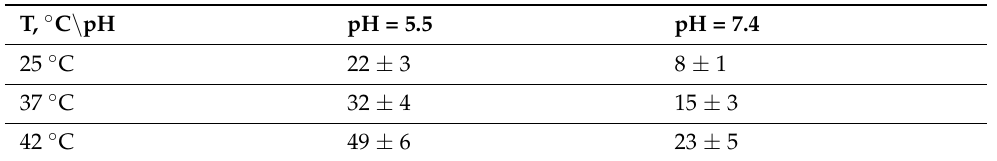
Table 3. Initial rate of Dox release (%/h) at pH = 7.4 or 5.5 and T = 25, 37, or 42 ◦ C. The conditions are similar to those given in Figure